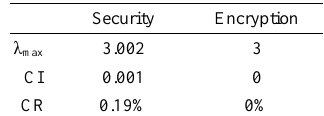
Table 10. Consistency evaluation for Case 2